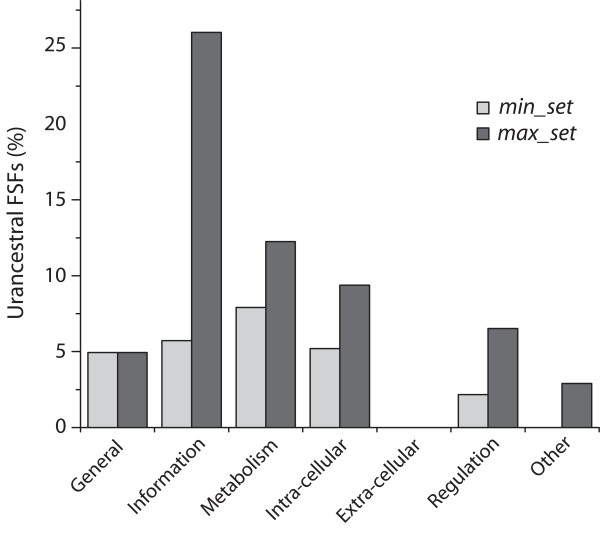
The general molecular functions of urancestral FSF sets relative to those present in the modern protein world. Bars describe the relative proportion of FSFs that are prent in urancestral sets and are annotated to the corresponding major functional categories were displayed on the top of the bars. For each of the major categories, the height of a bar was calculated by dividing the number of FSFs in urancestral sets by the number of FSFs that are in the global set of 1,416 FSFs that are present in the 420 FL proteomes examined. Note that 4 FSFs were not assigned to any of the categories.